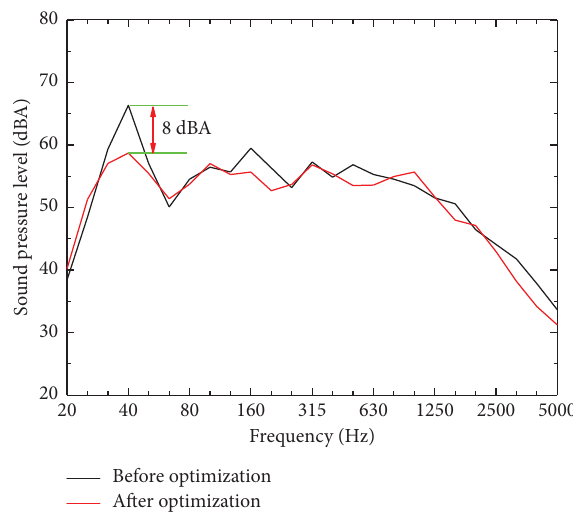
Figure 9: Comparison of noise spectrum on the inner side of the car body end wall before and after